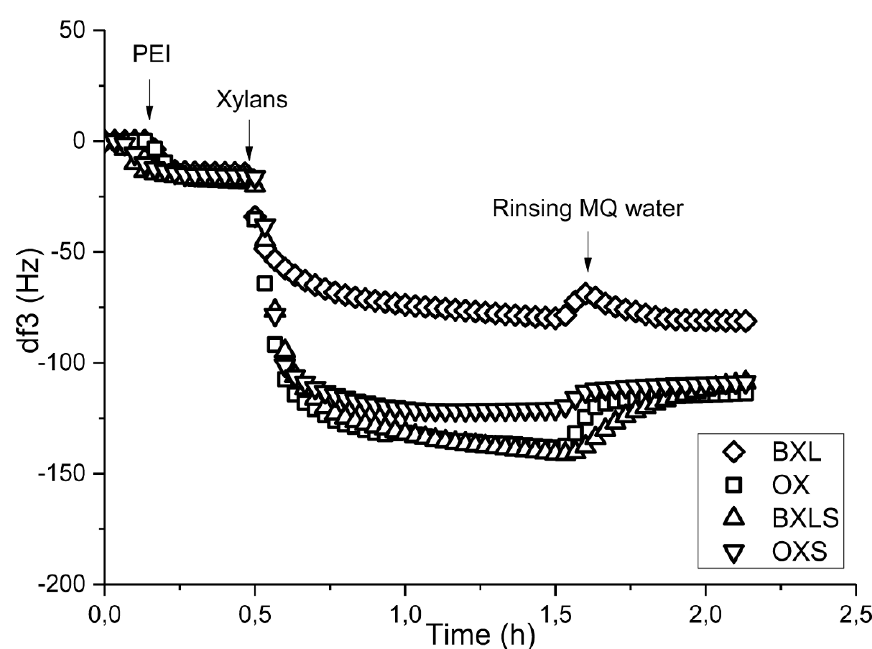
Figure 5. Frequency change at third overtone (df3) as a function of time during adsorption of non-modified and sulfated xylans onto the PET surface after adsorption of polyethyleneimine (PEI) as an anchoring agent.